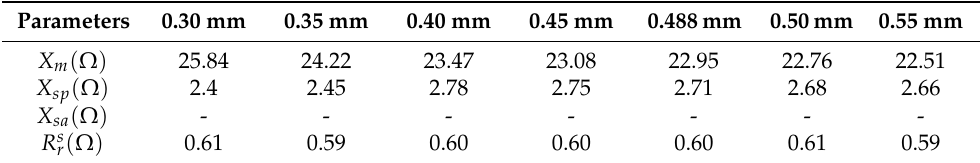
Table 6. Parameters of the motor from the FEA with 0 µ F.